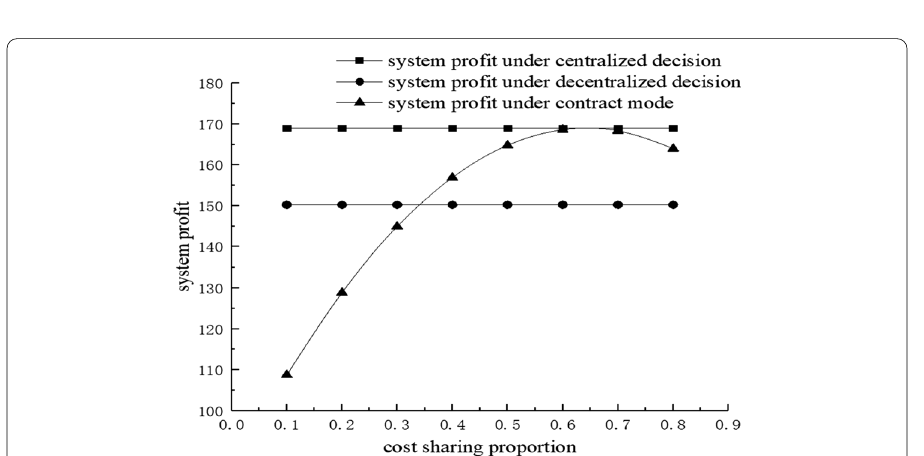
Fig. 8 Change of system profit π sc with cost share proportion